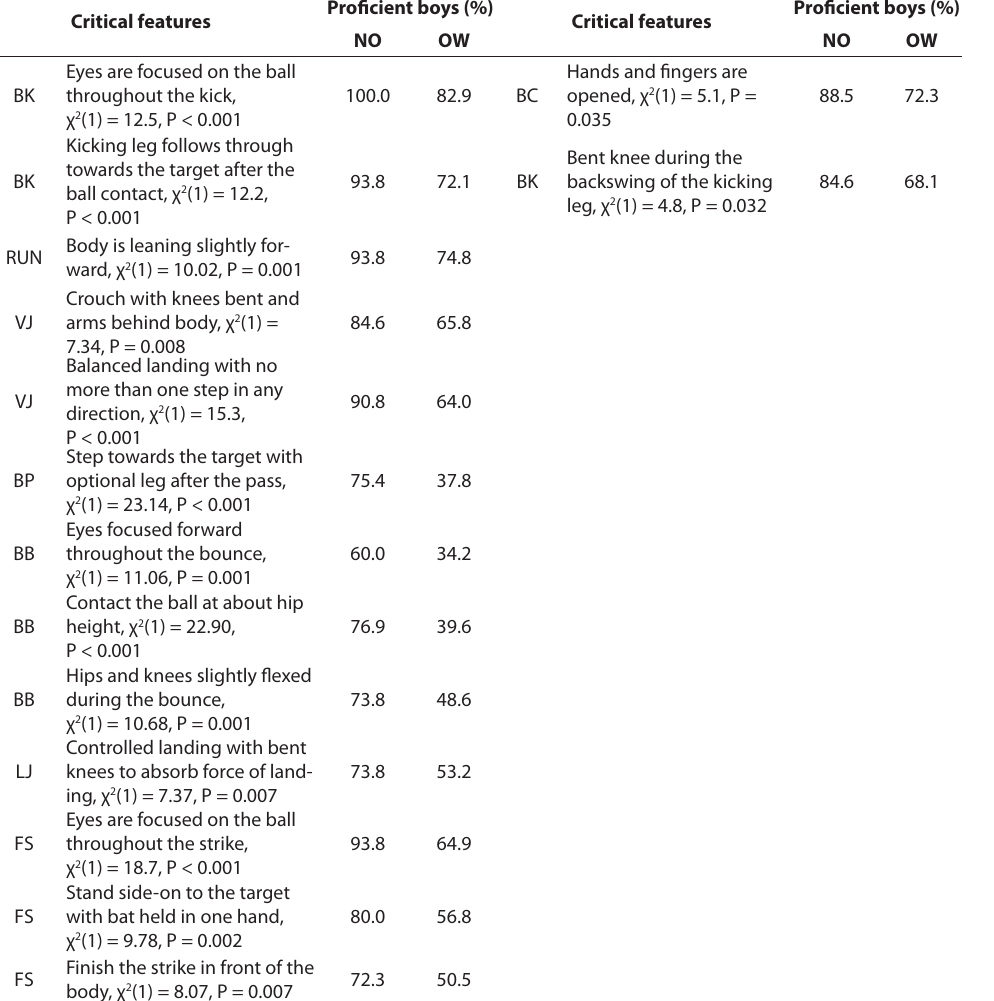
TABLE 2 Differences in FMS proficiency between boys and girls across body composition Critical